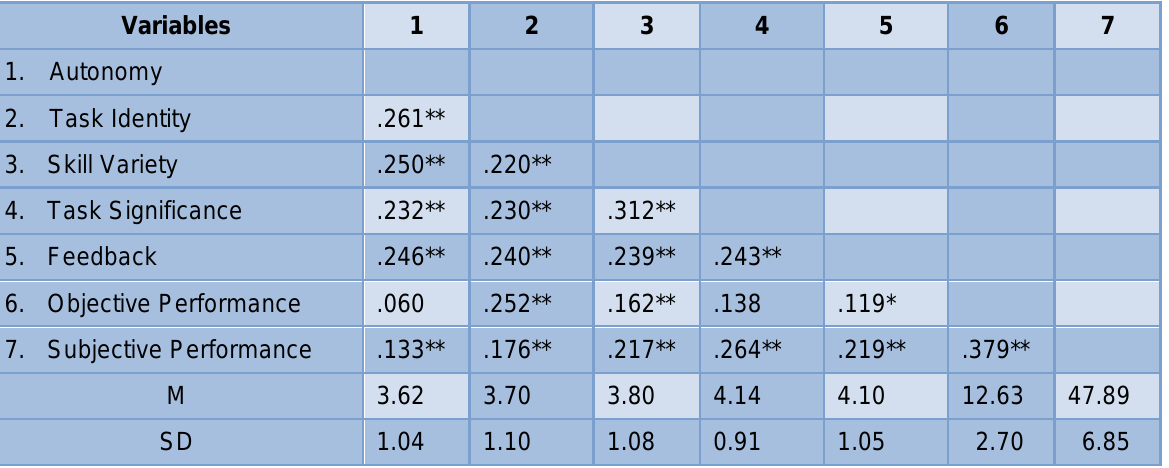
Table 3 Means, standard deviations, and bivariate correlations among study variables M = mean, SD = standard